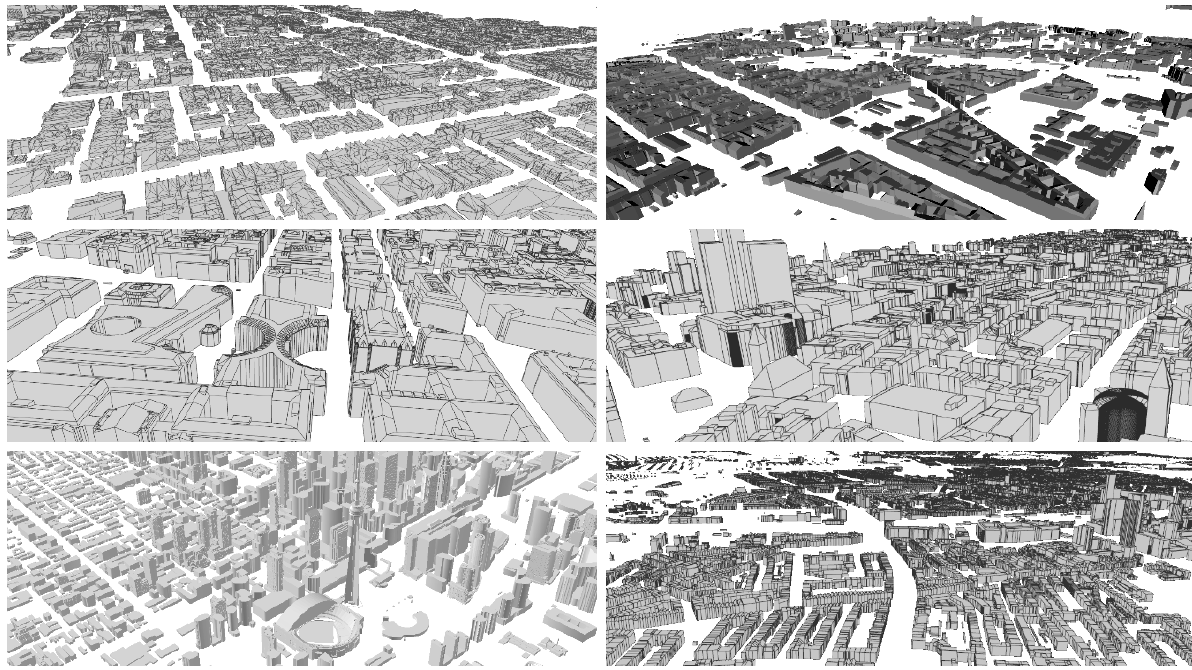
Figure 1. Excerpts of the six datasets (clockwise from top-left: Adelaide, Berlin, Frankfurt, Rotterdam, Toronto and Washington D.C.)